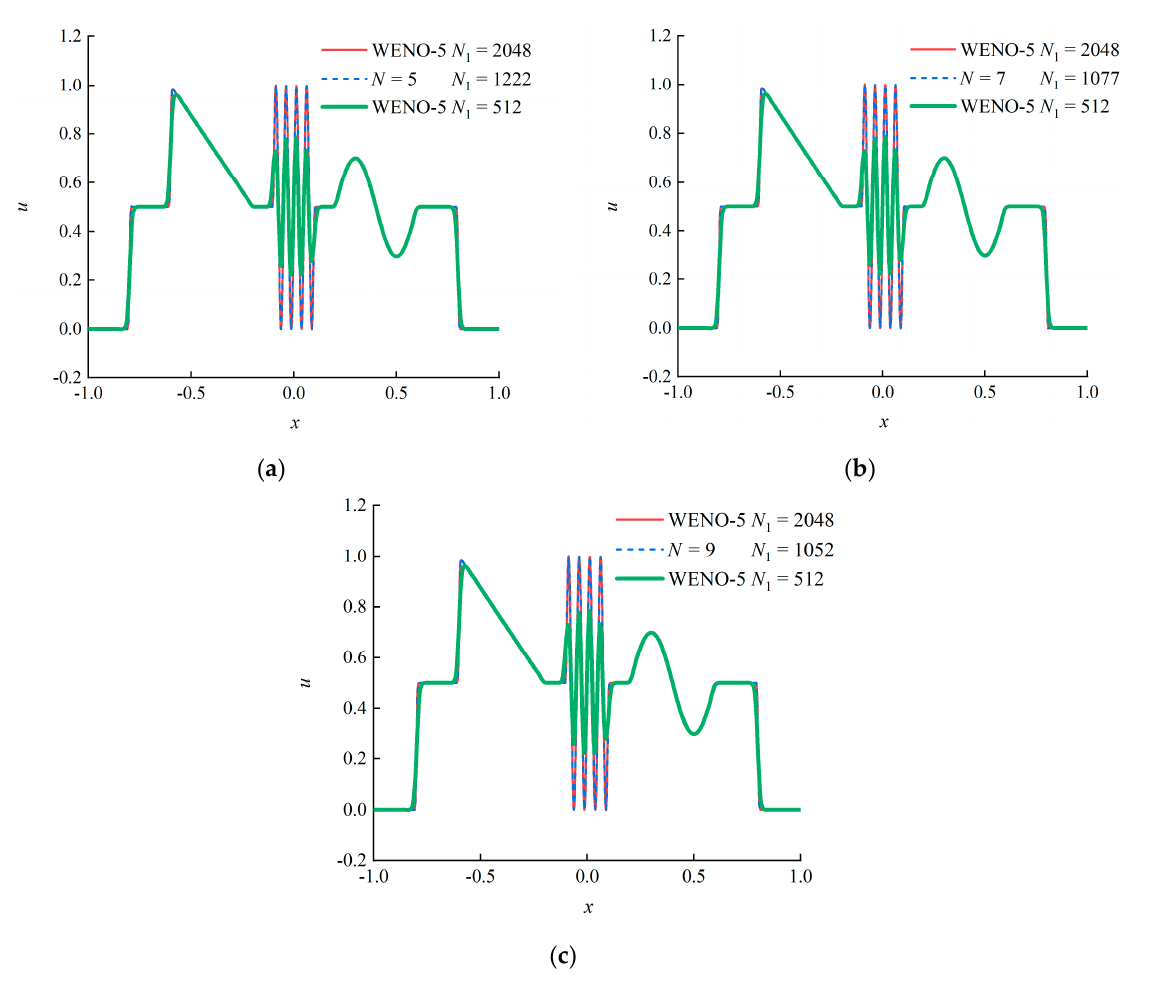
Figure 10. Numerical results by the schemes with N ∈ odd and BM = 1 at t = 2 ( J 0 = 6, J max = 12): ( a ) N = 5; ( b ) N = 7; ( c ) N = 9.